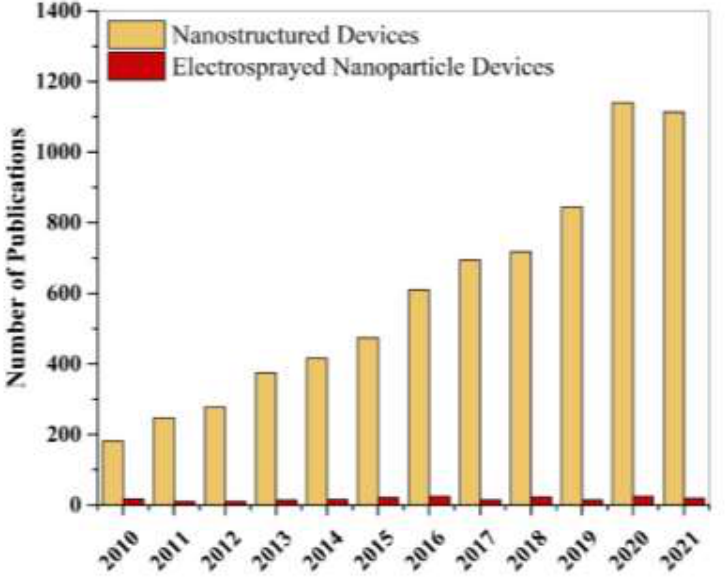
Figure 1: The number of publications per year from Web of Science on nanostructures and electrospray nanoparticles applied in drug delivery systems. Data accessed on 20 November